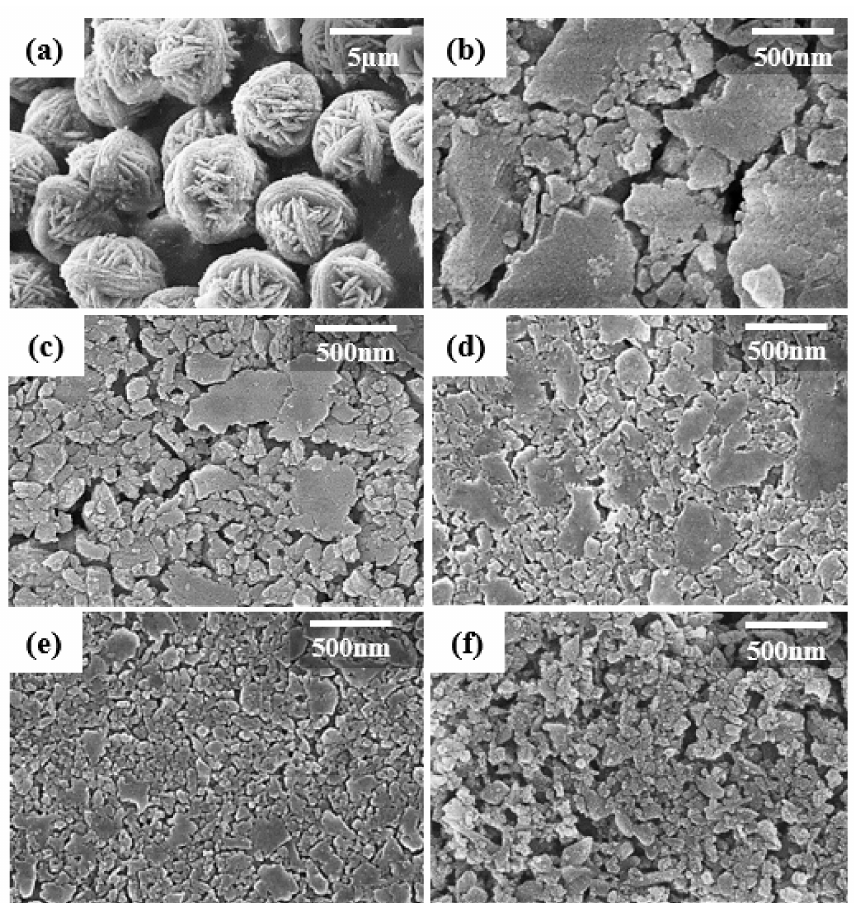
Figure 1. SEM images of ( a ) original CHA zeolite particles and planetary-milled seeds with different milling speed and time; ( b ) S1 = 200 rpm for 6 h, ( c ) S2 = 200 rpm for 12 h, ( d ) S3 = 200 rpm for 24 h, ( e ) S4 = 400 rpm for 36 h, and ( f ) S5 = 400 rpm for 100